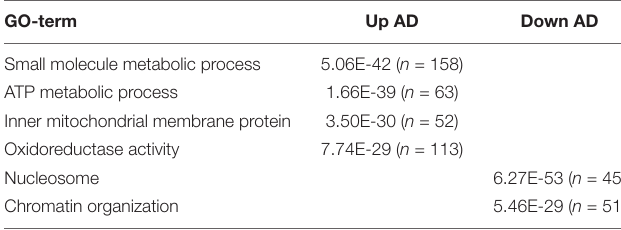
TABLE 2 | Main gene ontology terms among the 1000 most strongly expressed genes in adult hemocytes (AD), peripheral hemocytes (PH) and lymph glands (LG). GO-term AD top